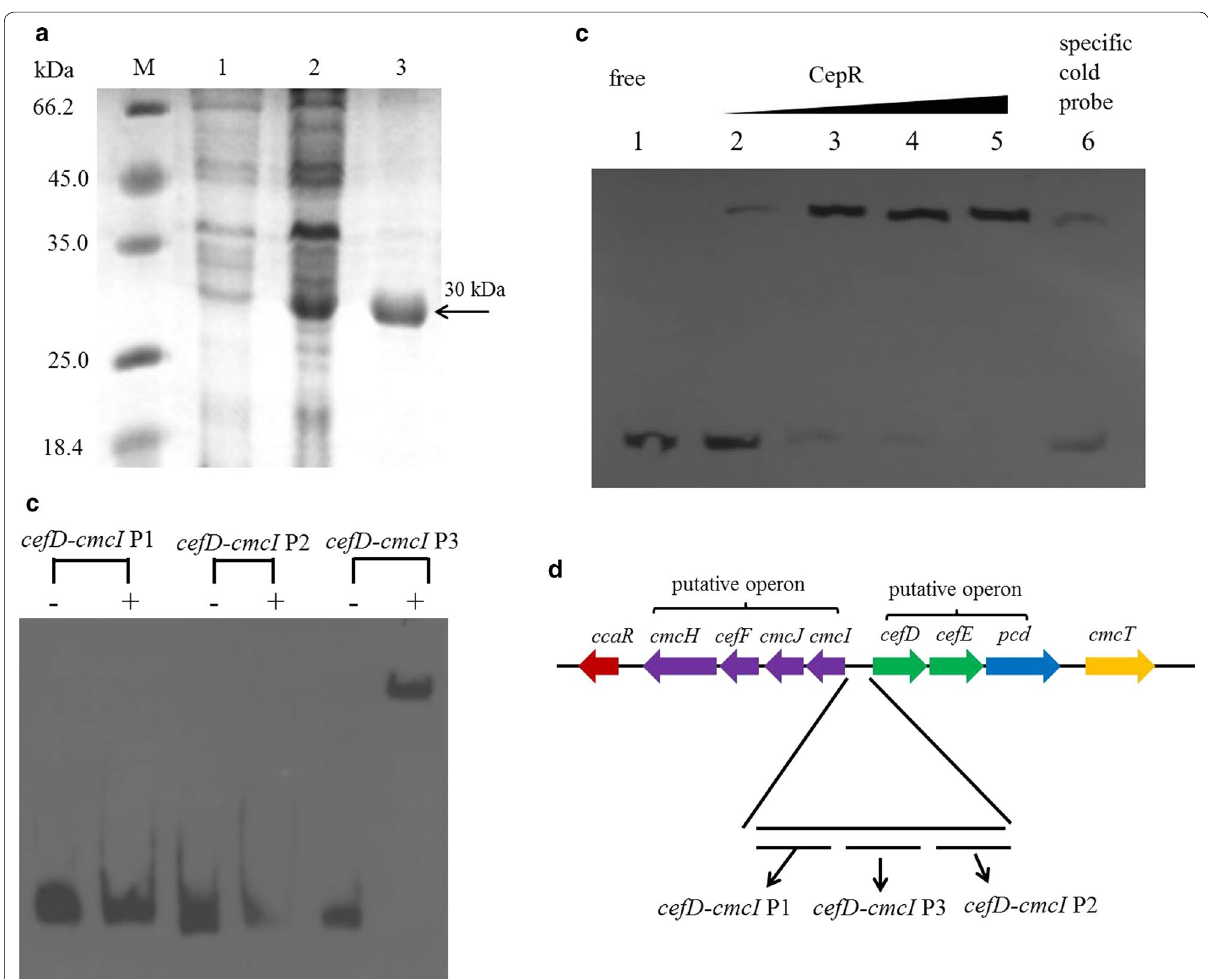
Fig. 4 Binding of CepR to the cefD - cmcI promoter regions. a Expression and purification of His-tagged CepR analyzed by sodium dodecyl sulfate polyacrylamide gel electrophoresis. Lane 1, control sample. Lane 2, His-tagged CepR induced by the addition of IPTG. Lane 3, purified fusion protein. Lane M, protein marker. b Electrophoretic mobility shift assay analysis of the binding of His-tagged CepR to the promoter regions of cefD - cmcI . The P1, P2, and P3 cefD - cmcI intergenic regions were 208 bp, 315 bp, and 318 bp, respectively. The probes were incubated either with no protein ( with 3.0 μg of CepR ( ).1.0 µg polydI/dC was used as a competitor. c A fixed amount of probe P3 was incubated with no CepR (Lane 1), 0.5–3.0 µg + of CepR (Lanes 2–5), or 3.0 μg of CepR and 100-fold excess of unlabeled specific probe (Lane 6). 1.0 µg polydI/dC was used as a competitor.